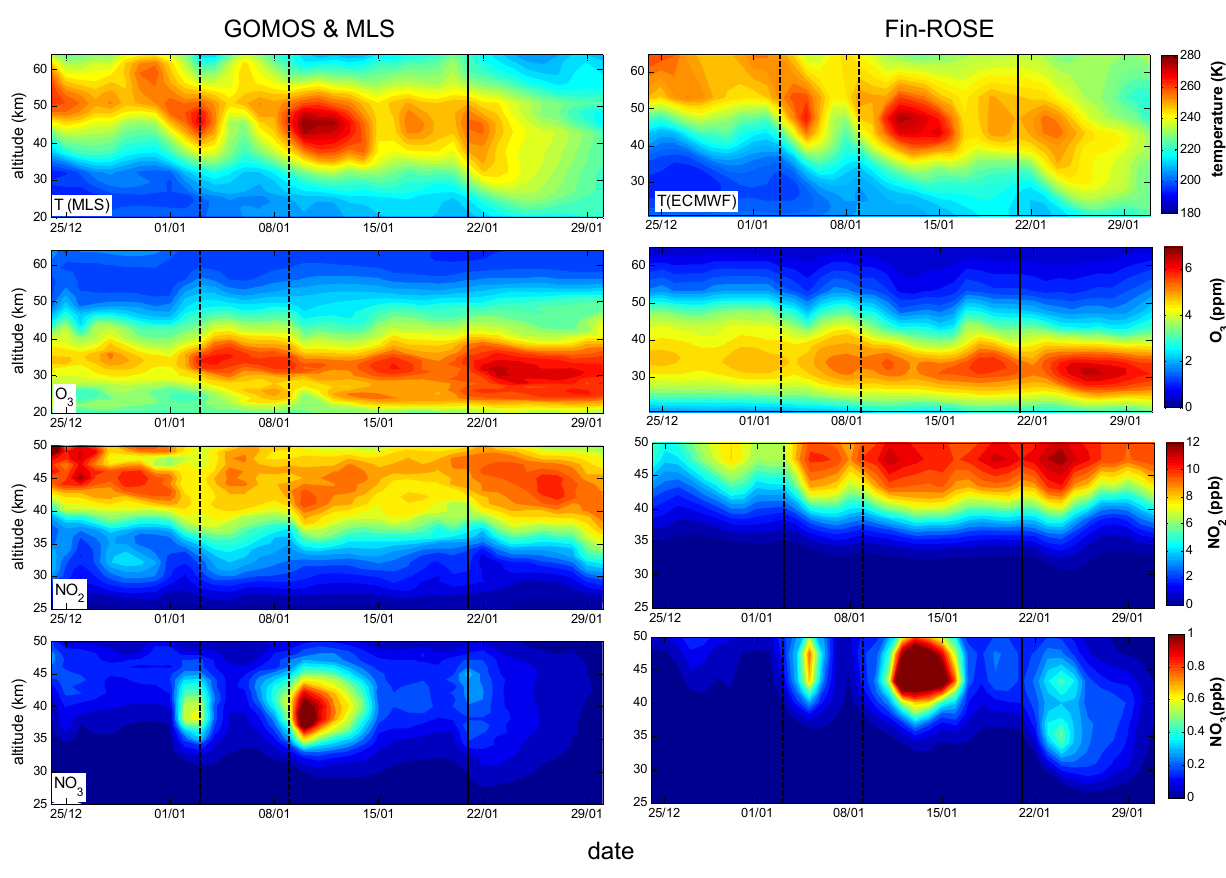
Figure 4 Changes in the middle atmosphere during January 2006 SSW as observed by GOMOS Fig. 4. Changes in the middle atmosphere during January 2006 SSW as observed by GOMOS and MLS (left), and as simulated with and MLS (left), and as simulated with FinROSE (right). The results present zonally averaged data FinROSE (right). The results present zonally averaged data in the latitudinal band 70 ◦ –90 ◦ in the latitudinal band 70°-90°N